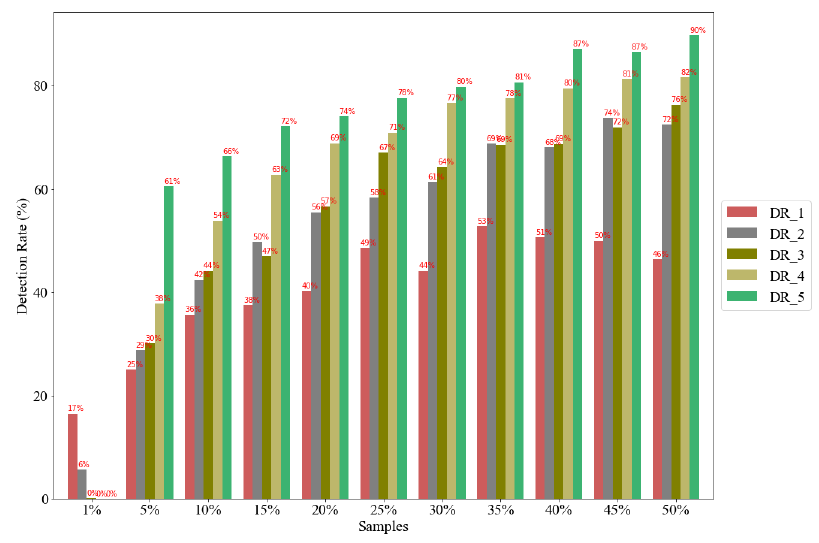
Figure 8. Detection Rate (DR) for all gridlock